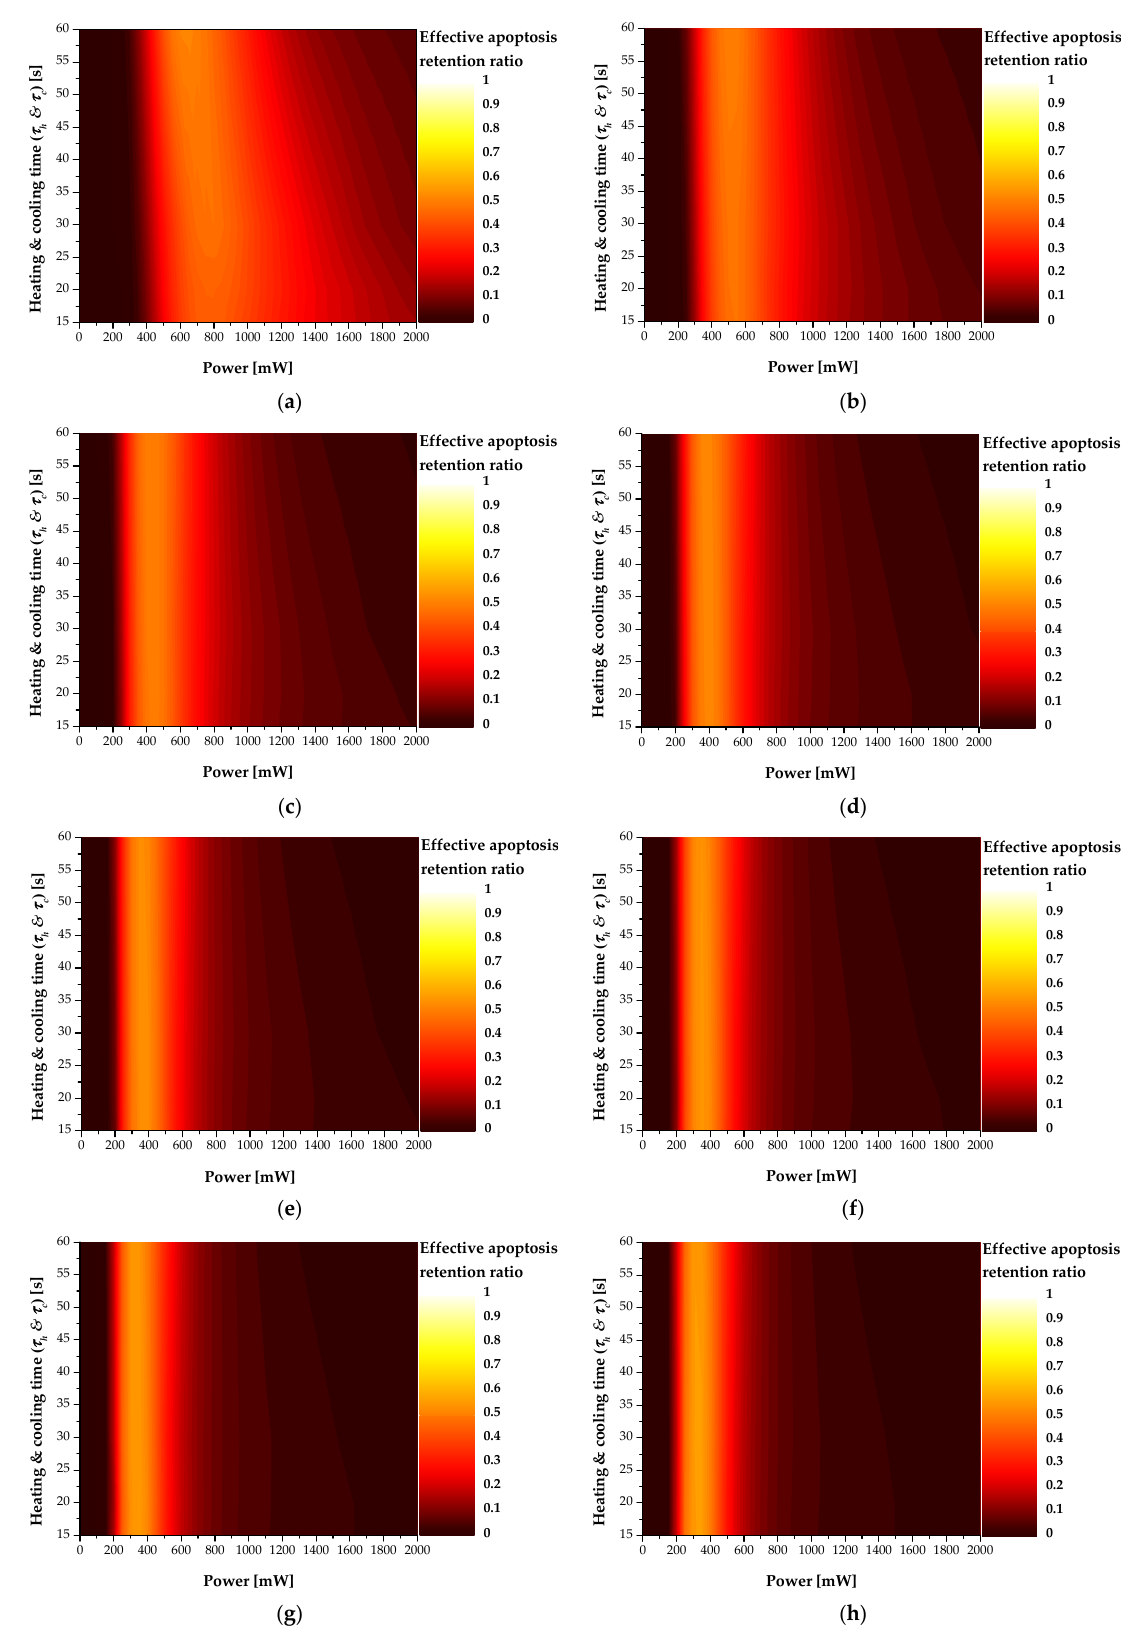
Figure 13. Effective apoptosis retention ratio ( θ ∗ ) for various total treatment time ( τ tot ) ( f v = 10 − 6 ) ( a ) τ tot = 120 s; A , ef f ( b ) τ tot = 240 s; ( c ) τ tot = 360 s; ( d ) τ tot = 480 s; ( e ) τ tot = 600 s; ( f ) τ tot = 720 s; ( g ) τ tot = 840 s; ( h ) τ tot = 960